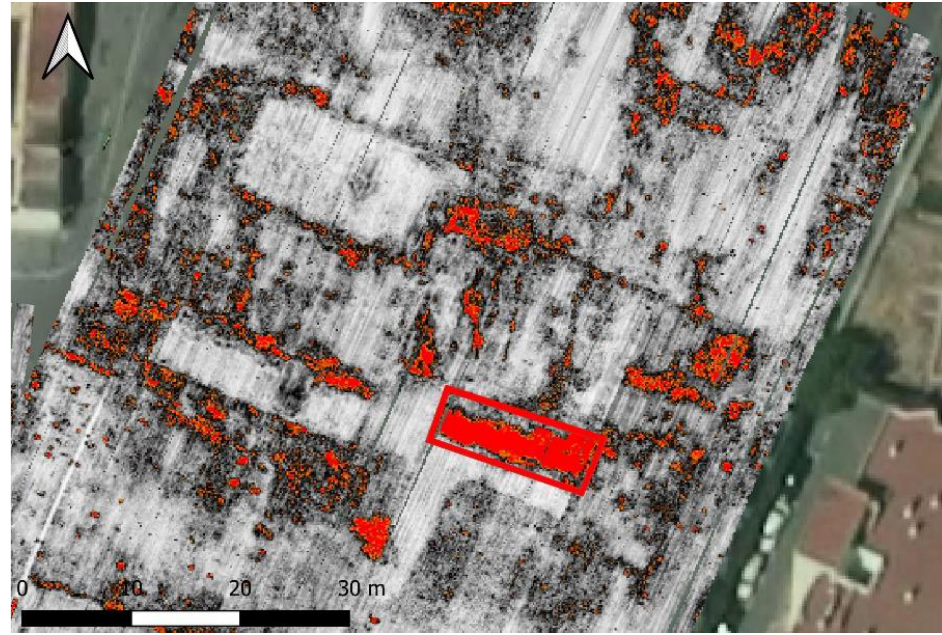
Figure 8. Central part of Set 3, highlighting (in red) a large and deep alteration at -0.89 m.